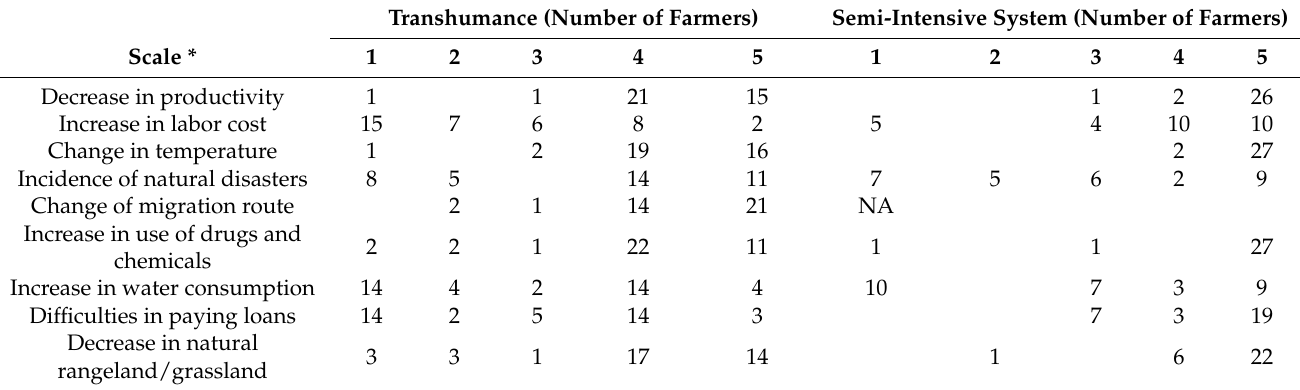
Table 2. Perceived impact of climate change according to farmers.